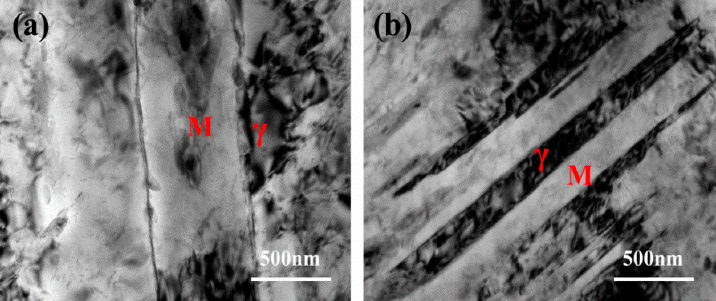
Figure 9. TEM micrographs of retained austenite in samples tempered at 600 °C for 4 h: ( a ) Nitrogen-free steel; ( b ) nitrogen-alloyed steel.